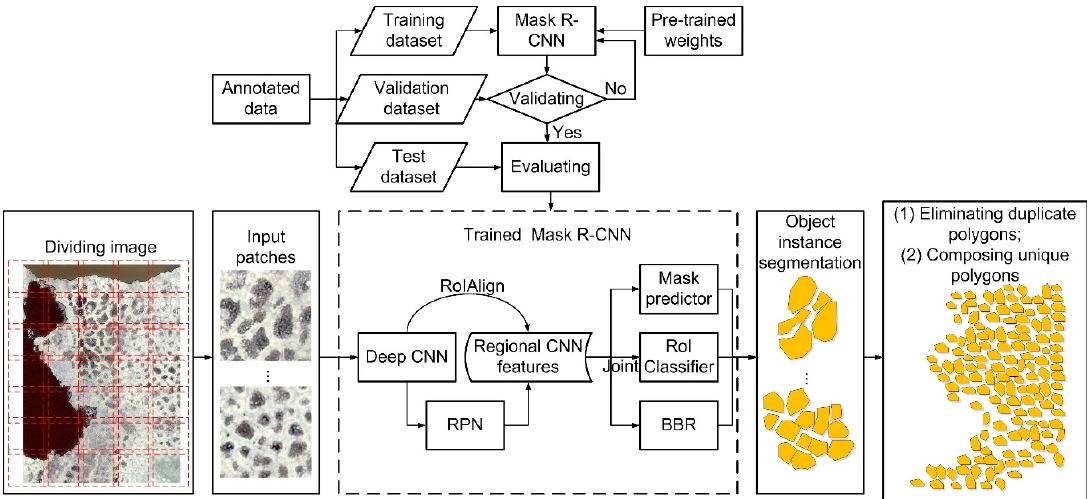
Figure 4. Ice-wedge polygon automated mapping workflow with the implementation of the Mask Region-Based Convolutional Neural Network (R-CNN). In this figure, RoI stands for region of interest; CNN stands for convolutional neural network; RPN stands for region proposal network; BBR stands for bounding box regressor. Table 3. The number of epochs in re-training processes until the validation losses converge for obtaining the best Mask Region-Based Convolutional Neural Network (R-CNN) models correspondingly. The Number of Epochs in The Number of Epochs in Case Study Pre-Training Processes Re-Training Processes C1